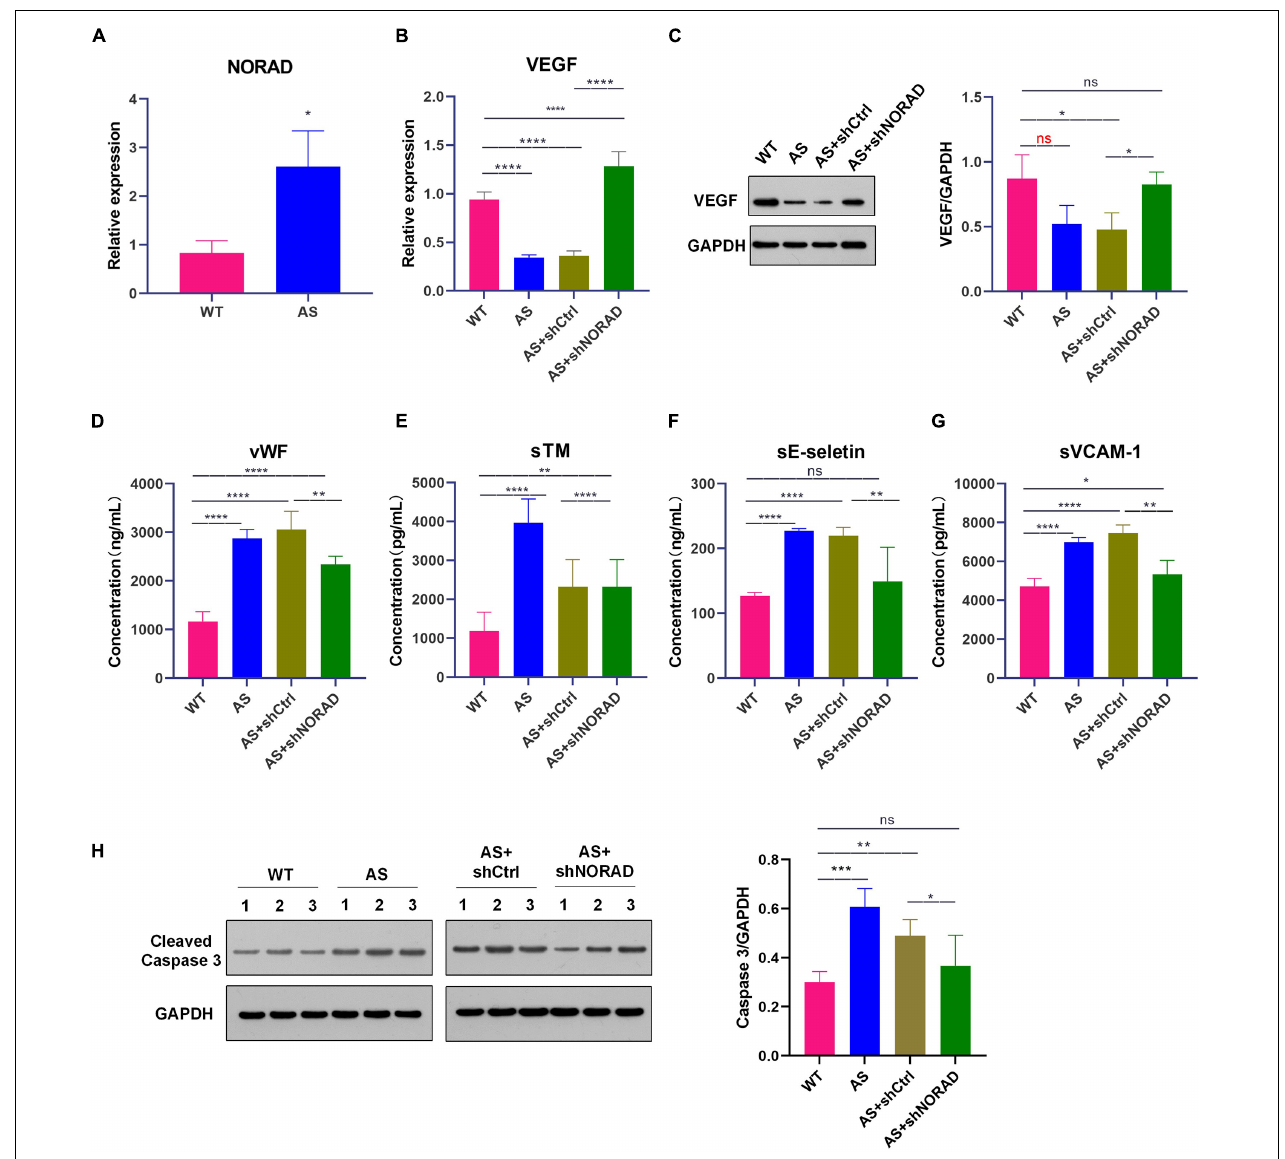
FIGURE 7 | Knockdown of lncRNA NORAD aggravates VEGF expression in thoracic aorta of atherosclerotic mice. (A) The level of lncRNA NORAD in thoracic aorta of mice. (B) The mRNA level of VEGF in mice injected with control shRNA or shRNA-targeting lncRNA NORAD. (C) The protein level of VEGF in mice injected